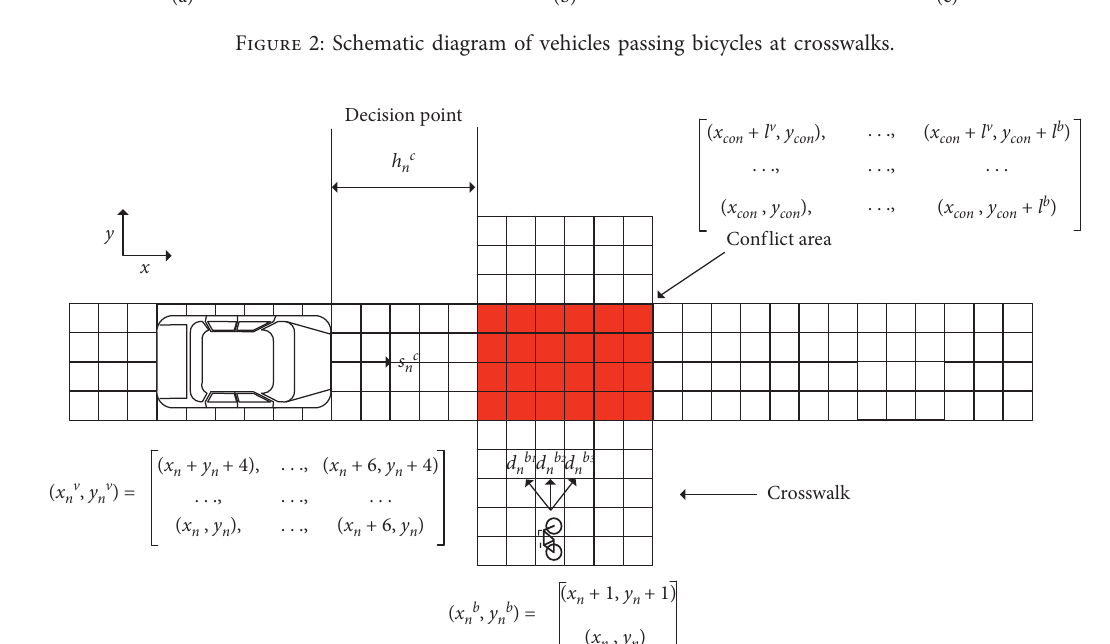
Figure 3: Schematic diagram of mixed-flow cellular space.